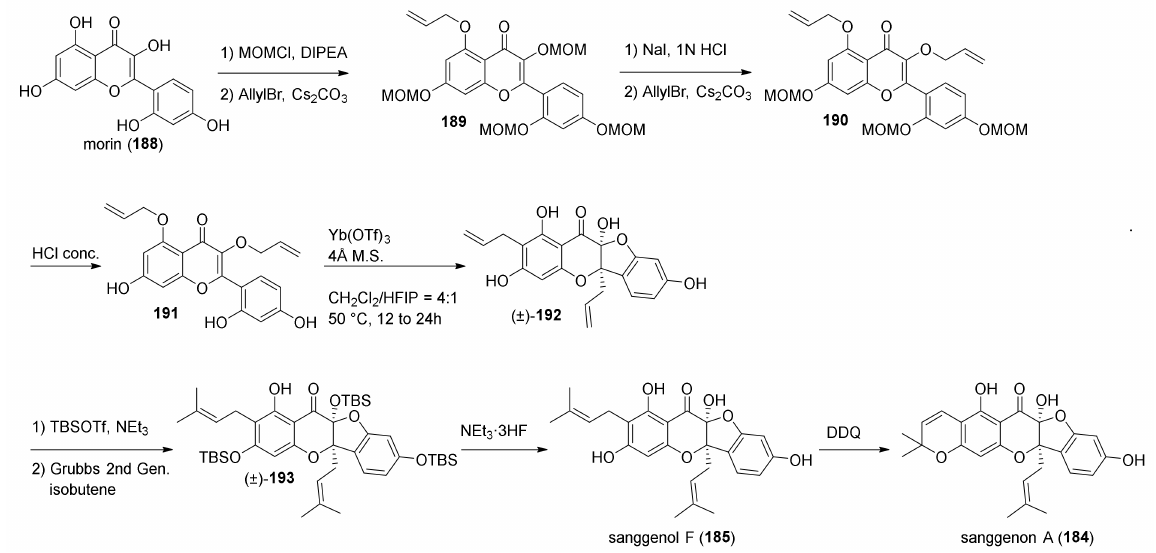
Figure 63. Synthesis of sanggenons A and